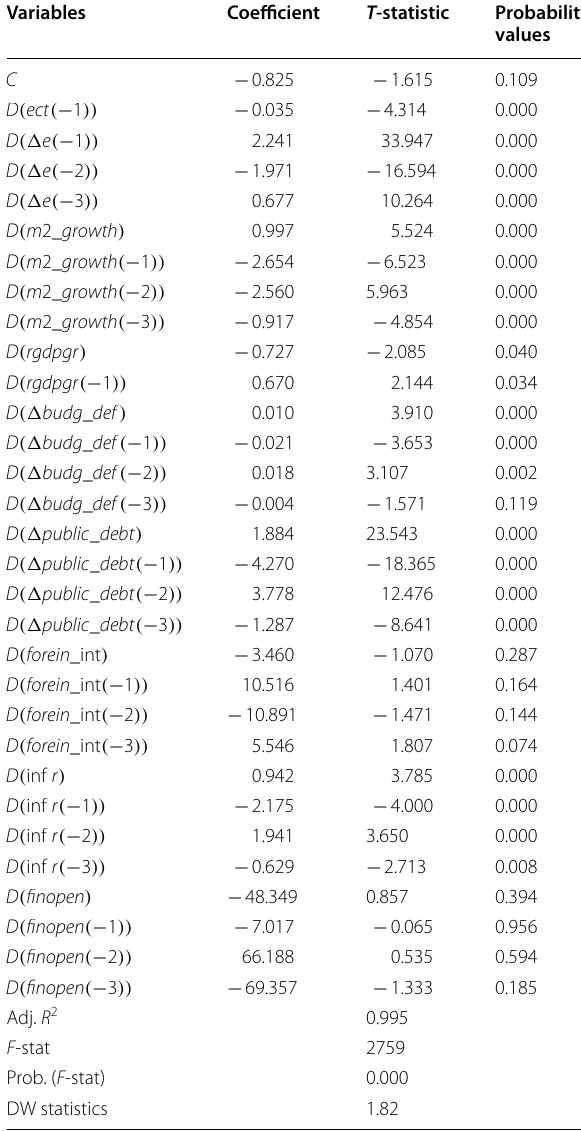
Table 4 Conditional error correction regression. Source: